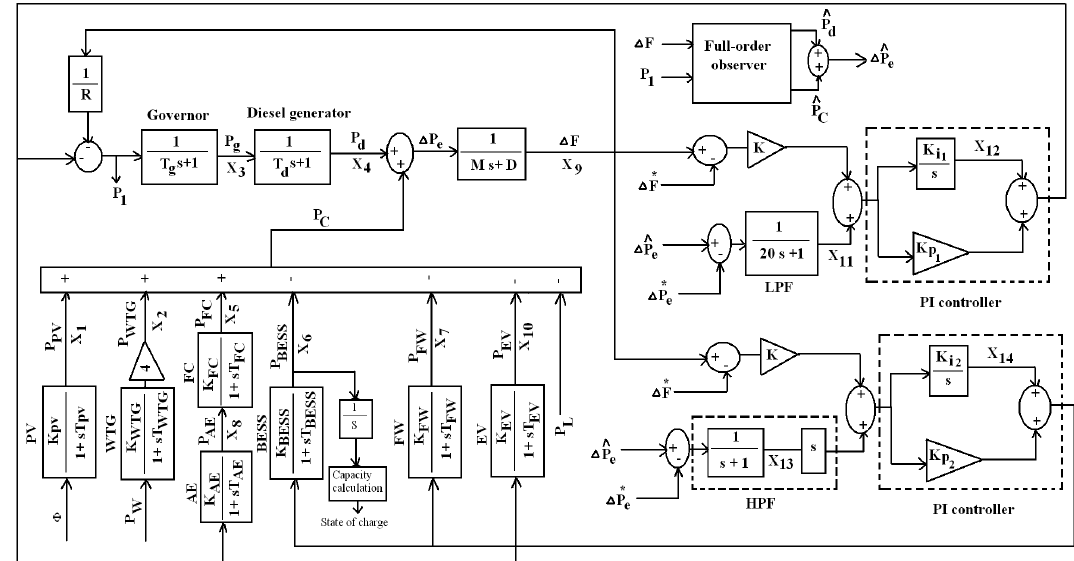
Figure 2. Block diagram of the proposed system. PV: photovoltaic; WTG: wind turbine generators; AE: aqua-electrolyzer; FC: fuel cell; BESS: battery energy storage system; FW: flywheel; EV: electric vehicle; LPF: low-pass filter; and HPF: high-pass